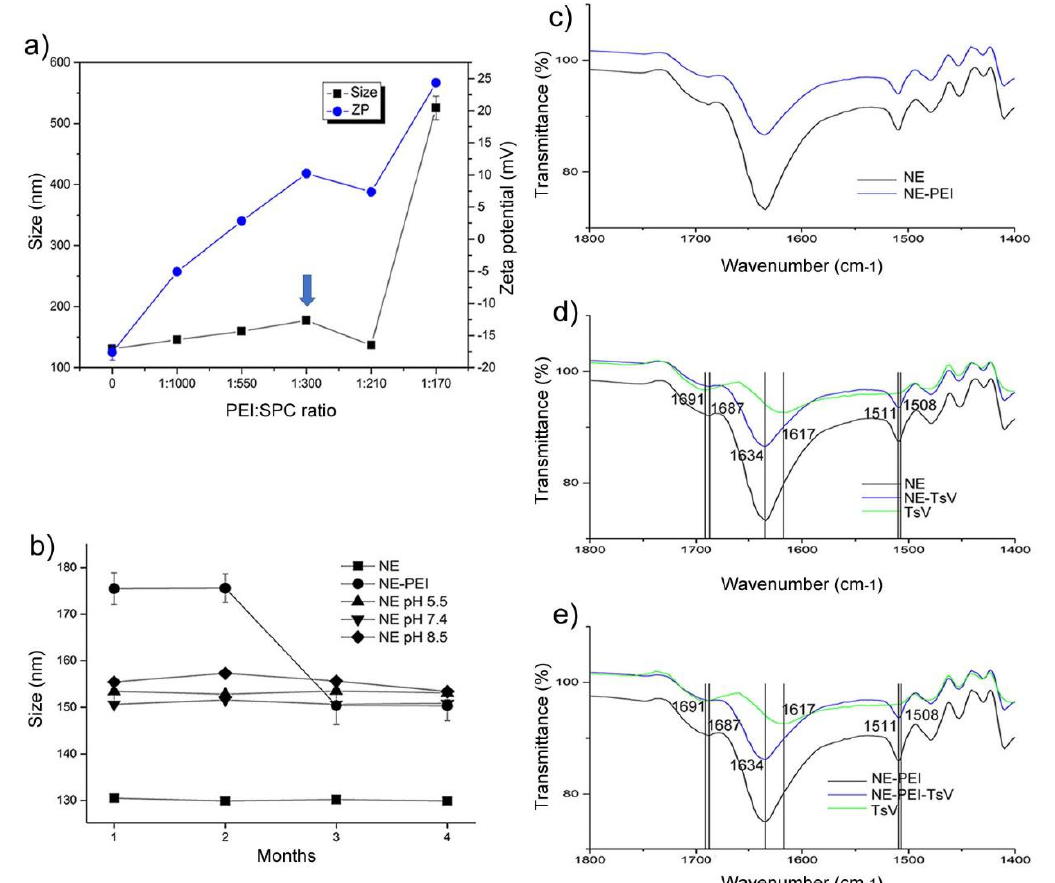
Figure 3. Effect of PEI covering and TsV-loading on the physicochemical properties of the NE formulations. ( a ) Effect of PEI content on the size and zeta potential (ZP); ( b ) Stability and robustness of NE from pH changes; ( c – e ) Effect of the composition on the FTIR spectra of distinct NEs: ( c ) PEI addition; ( d ) NE-TsV loading; ( e ) NE-PEI-TsV-loading.